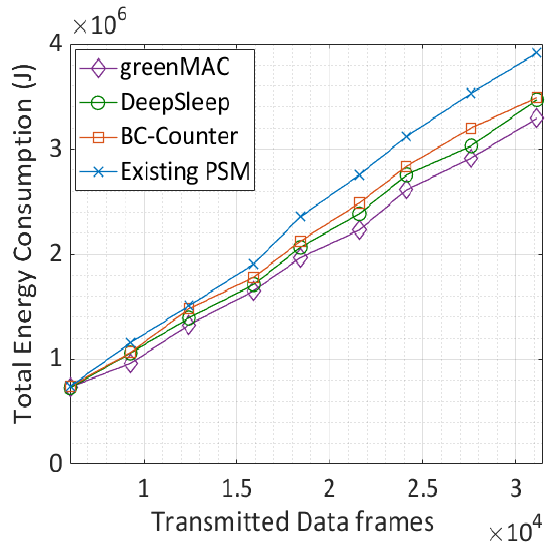
Figure 6. Comparison of total energy consumption in joules (J) of the proposed green MAC, existing PSM, DeppSleep, and BC-counter mechanisms in a network of thirty